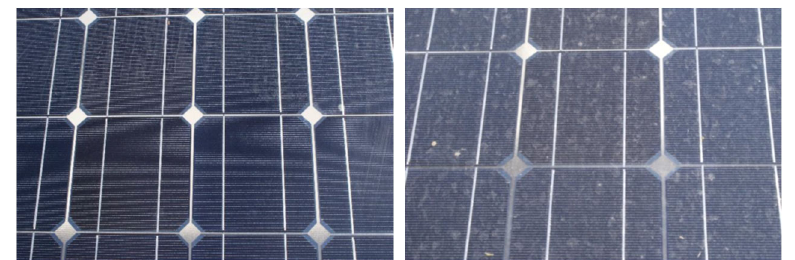
Figure 5. PV panels to study the impact of soiling on the output power: (left) cleaned PV panel and (right) dirty PV panel [19].